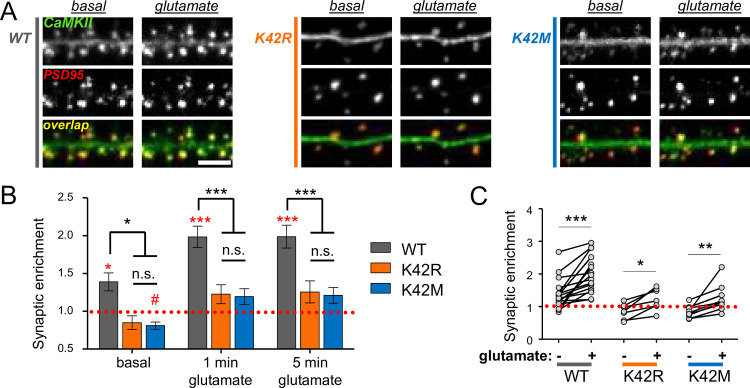
The K42M and K42R mutations reduce synaptic localization of CaMKII in cultured hippocampal neurons.(A) Example images before and after stimulation with 100 μM glutamate (in presence of 10 μM glycine) for 1 min. Scale bar: 4 μm. (B) Column statistics indicate that only CaMKII wild type is significantly synaptically enriched (spine to shaft ratio >1) at any given time point; *: p<0.01; ***: p<0.0001, in one sample t-test (red). The K42M mutant showed even significantly reduced synaptic localization (spine to shaft ratio <1) at one time point; #: p<0.01 (red). At any given time point, CaMKII wild type (n = 16) differed significantly from both the K42R (n = 7) and the K42M (n = 13) mutants, but the K42 mutants did not differ from each other; *: p<0.05; ***: p<0.001; n.s.: not significant, two-way ANOVA with Bonferroni post-hoc analysis (black). (C) Paired illustration of synaptic localization before and after glutamate values in the same neurons, indicating a mild but significant increases in synaptic localization also for the two K42 mutants; *: p<0.05; **: p<0.01; ***: p<0.001 two-way ANOVA with Bonferroni post-hoc analysis.